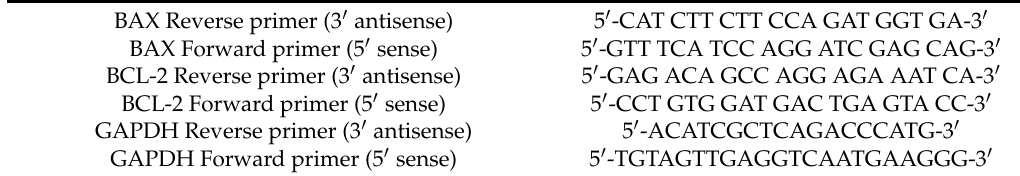
Table 1. Primer sequences used for